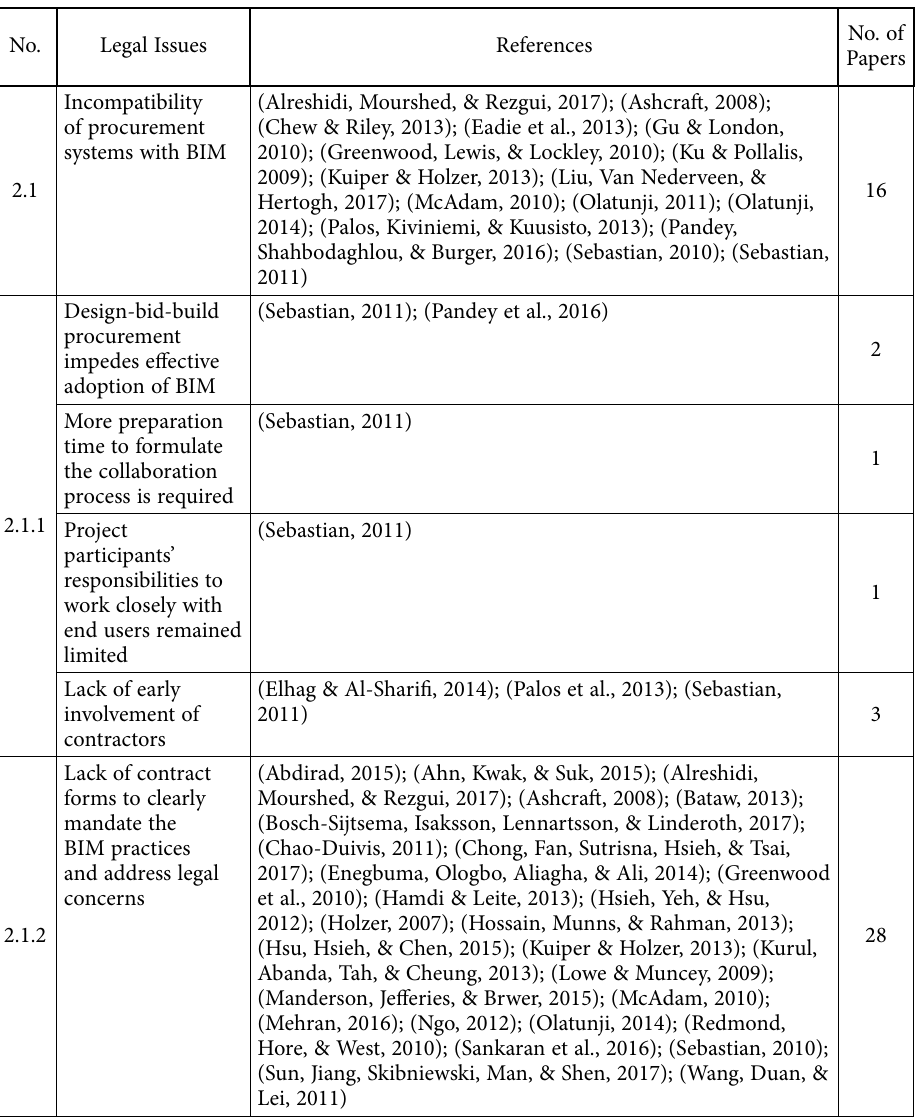
Table 1. Legal issues identified from the